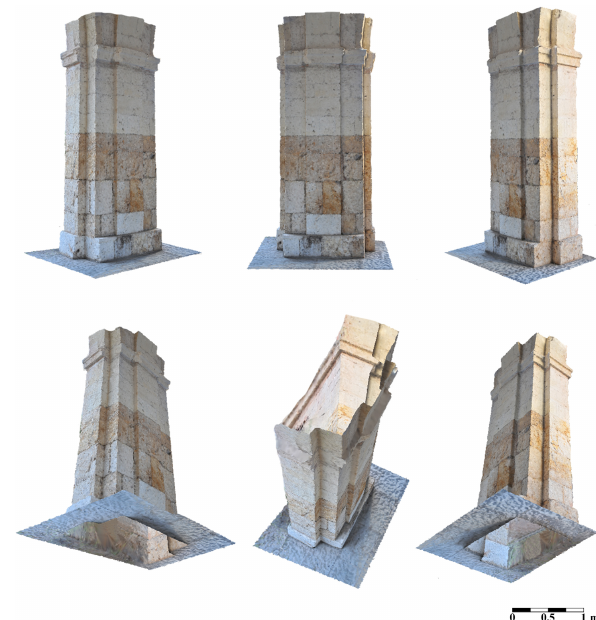
Figure 2. Final high resolution color 3-D model of the investigated pillar reconstructed with the DCI photogrammetric technique: dif- ferent views points of the pillar reconstructed with the DCI pho- togrammetric